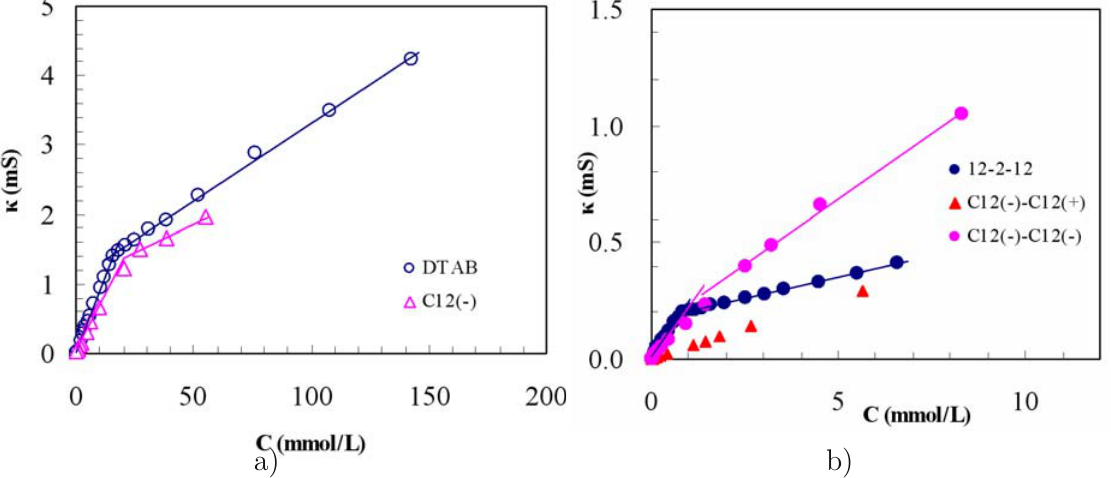
Fig. 2 The conductivity-concentration relationship of